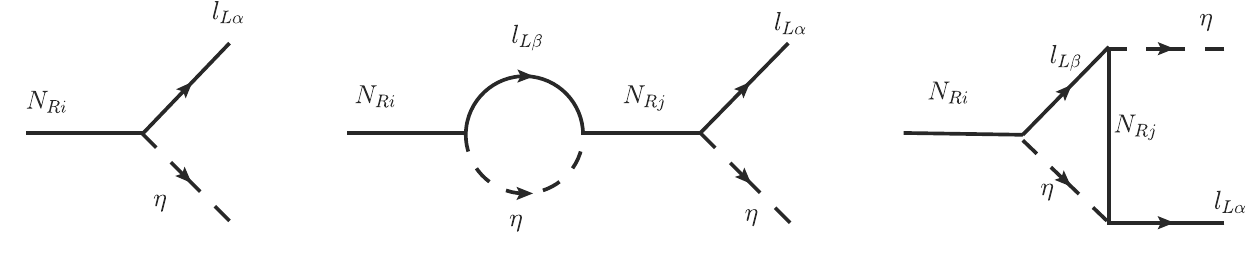
Fig. 1 Processes creating lepton asymmetry